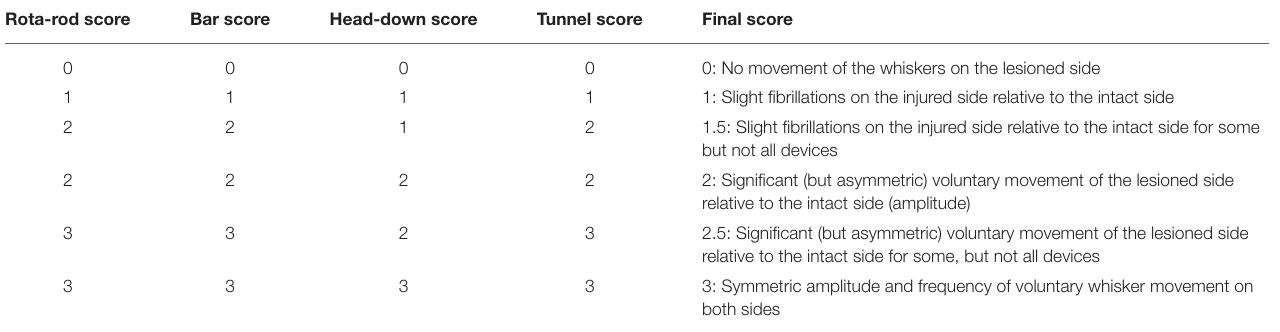
TABLE 3 | Videoscoring of whisker movement recovery—this scoring system differs from published scores because we took into account the separate scores obtained for each device to obtain a final score. Rota-rod